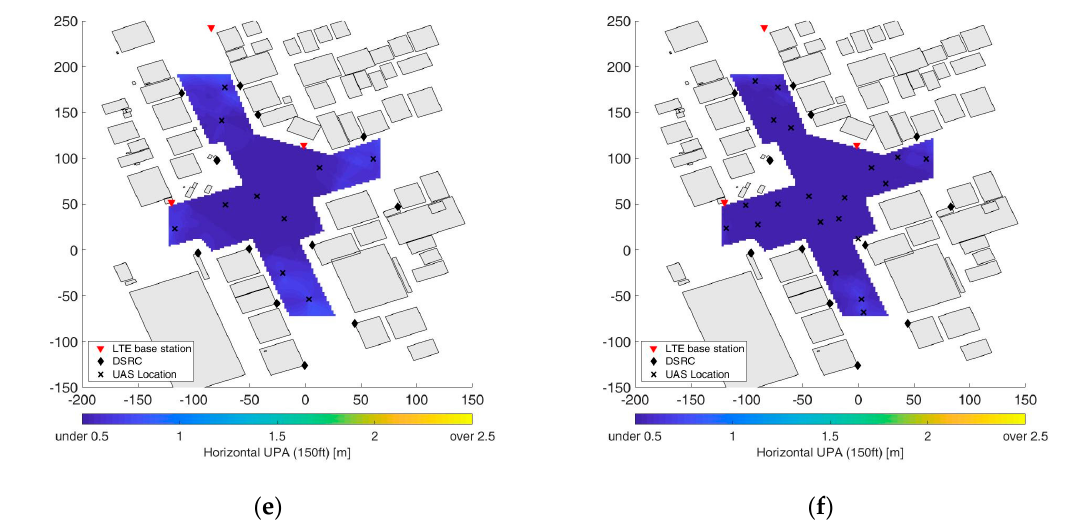
Figure 9. User positioning accuracy (UPA) improvement via cooperative positioning. The optimized network for 3 m (1 𝜎 ) horizontal positioning accuracy: ( a ) 10 UAS ( b ) 20 UAS; the optimized network for 2 m (1 𝜎 ) horizontal positioning accuracy: ( c ) 10 UAS ( d ) 20 UAS; the optimized network for 1 m (1 𝜎 ) horizontal positioning accuracy: ( e ) 10 UAS ( f ) 20 UAS.